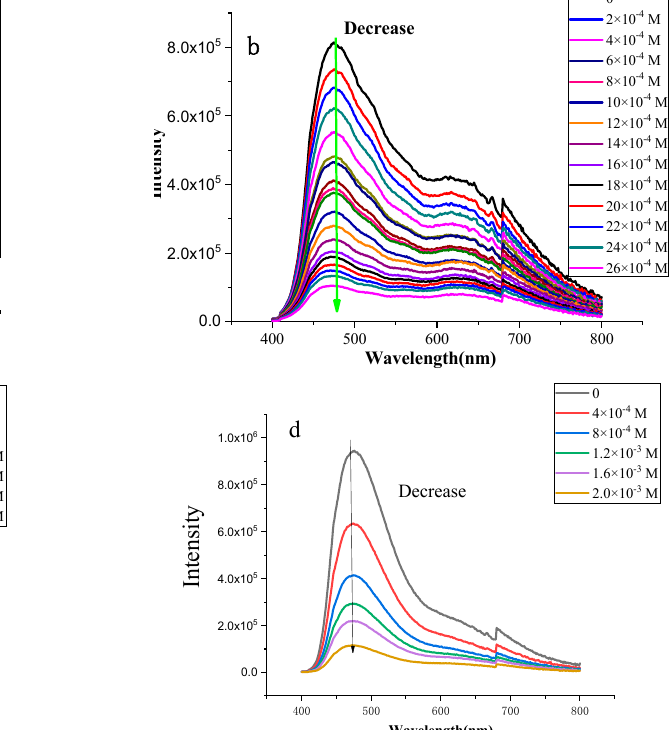
Figure 9. Fluorescence titration for ( a ) benzene, ( b ) nitrobenzene into CP-shu-1 dispersed in acetonitrile, and fluorescence titration for ( c ) benzene, ( d ) nitrobenzene into CP-shu-2 dispersed in acetonitrile.